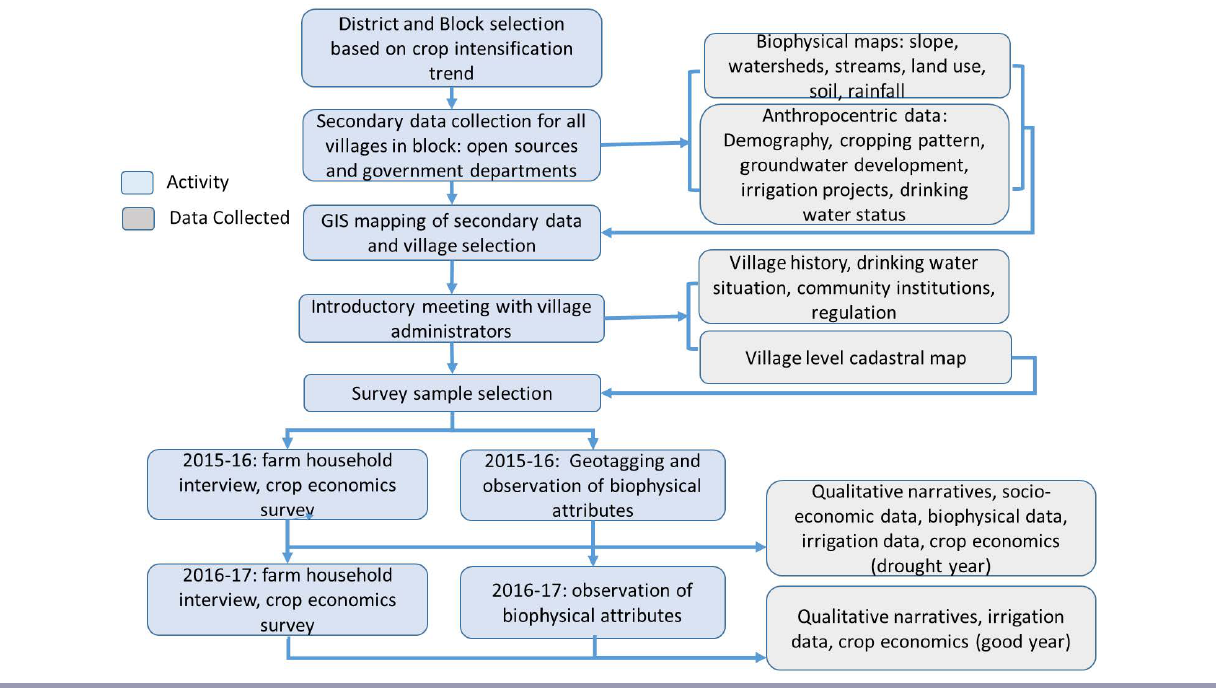
Fig. 3 . Data collection and field work